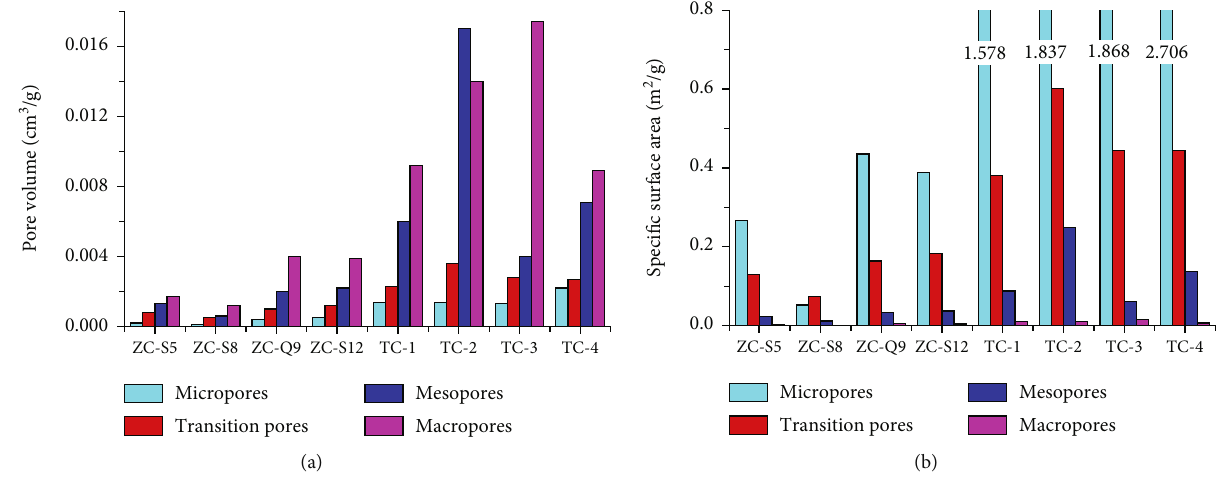
Figure 11: Pore volume (a) and speci fi c surface area (b) distributions for di ff erent pore sizes in the coal